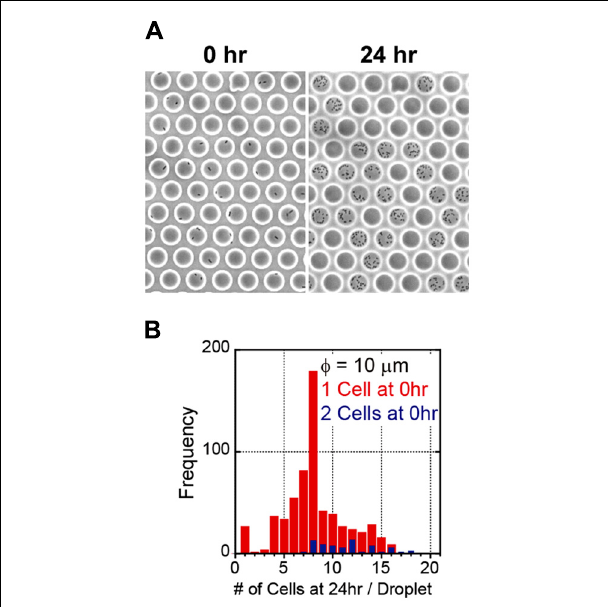
FIGURE 2 | Enclosure and culture of bacteria in a femtoliter droplet array. (A) Images of P. aeruginosa PAO1 after 0 h (left) and 24 h (right) of culture in the femtoliter droplet array. (B) Distribution of the number of cells after 24 h of culture.